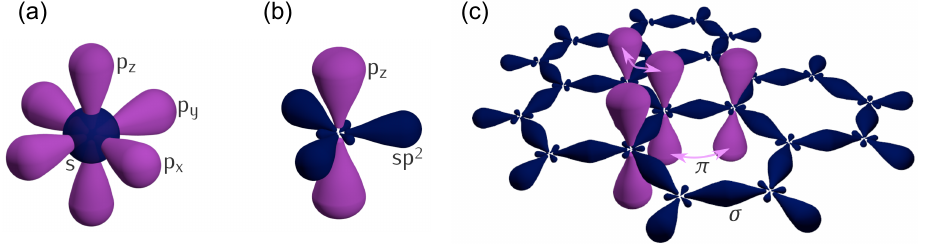
Figure 5. The hybridization of the outermost atomic orbitals in carbon atoms as they form graphene: ( a ) orbitals in a free carbon atom, which has 4 outermost electrons; ( b ) hybridization of the 2s, 2p x and 2p y orbitals to sp 2 orbitals comprising 3 electrons and a p z orbital containing one electron; ( c ) the sp 2 orbitals of neighboring atoms overlap to form σ bonds in graphene, whilst the p z orbitals form π bonds. Figure adapted from Wikipedia: https://en.wikipedia.org/wiki/Graphene, accessed on